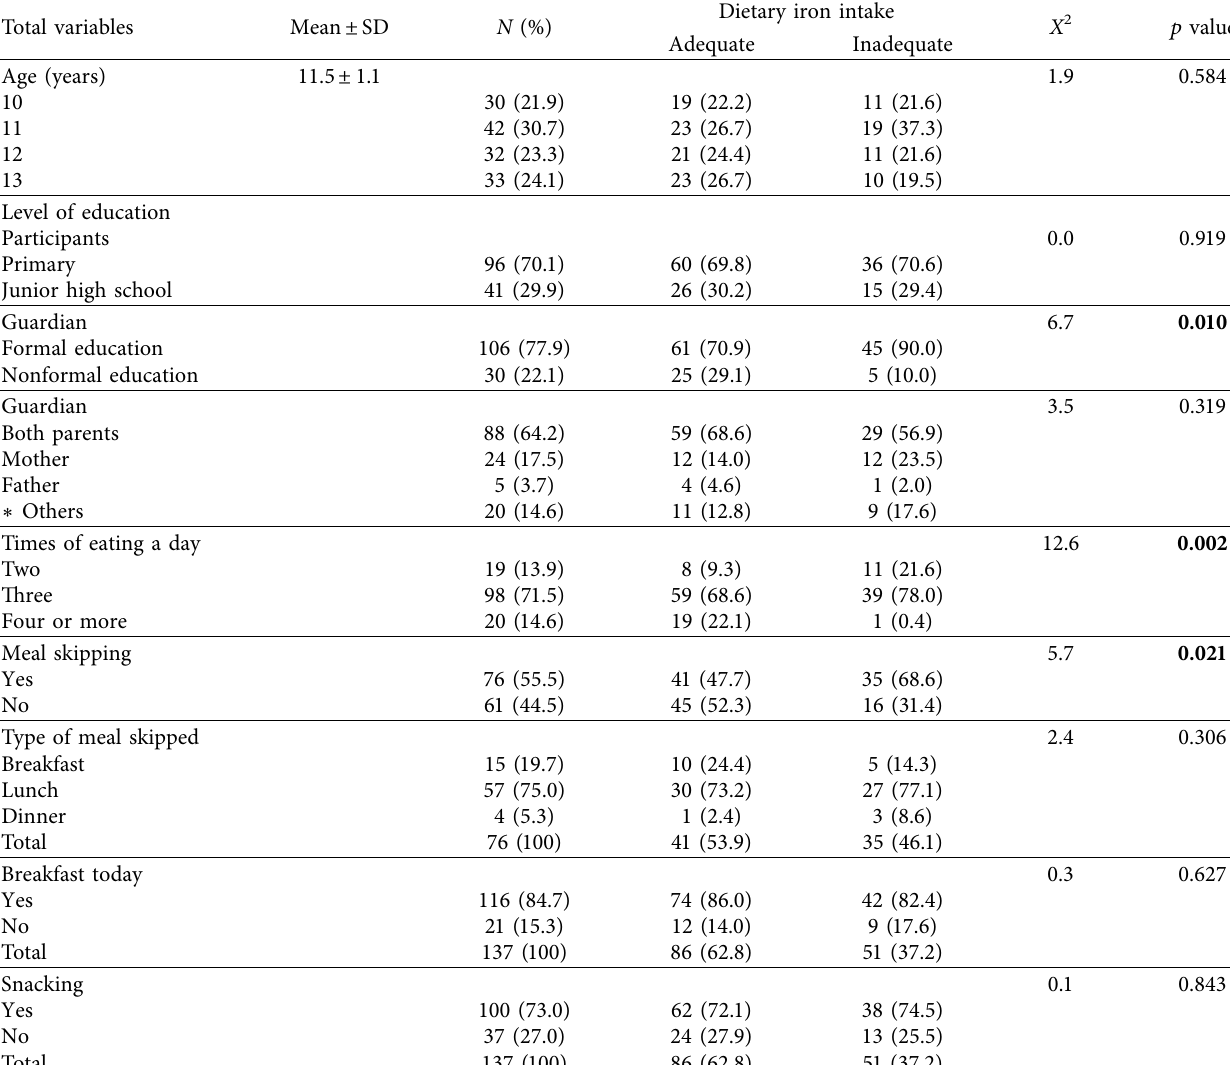
Table 1: Sociodemographic factors, dietary factors, and dietary iron intake.